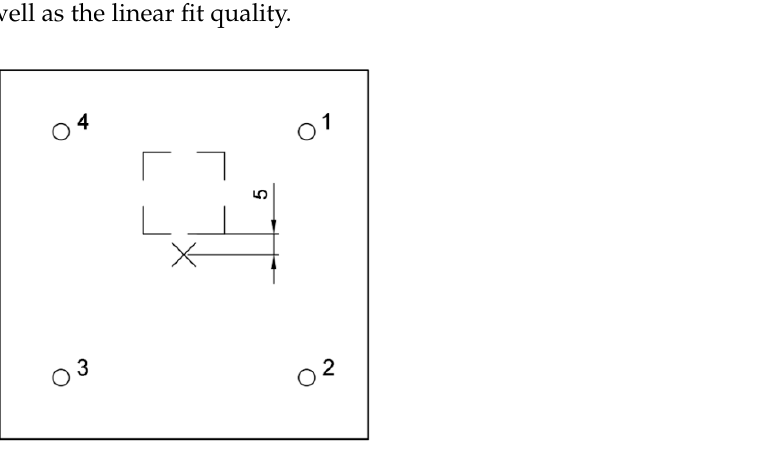
Table 6. Integral and RMS of frequency spectrum, edge below impactor.